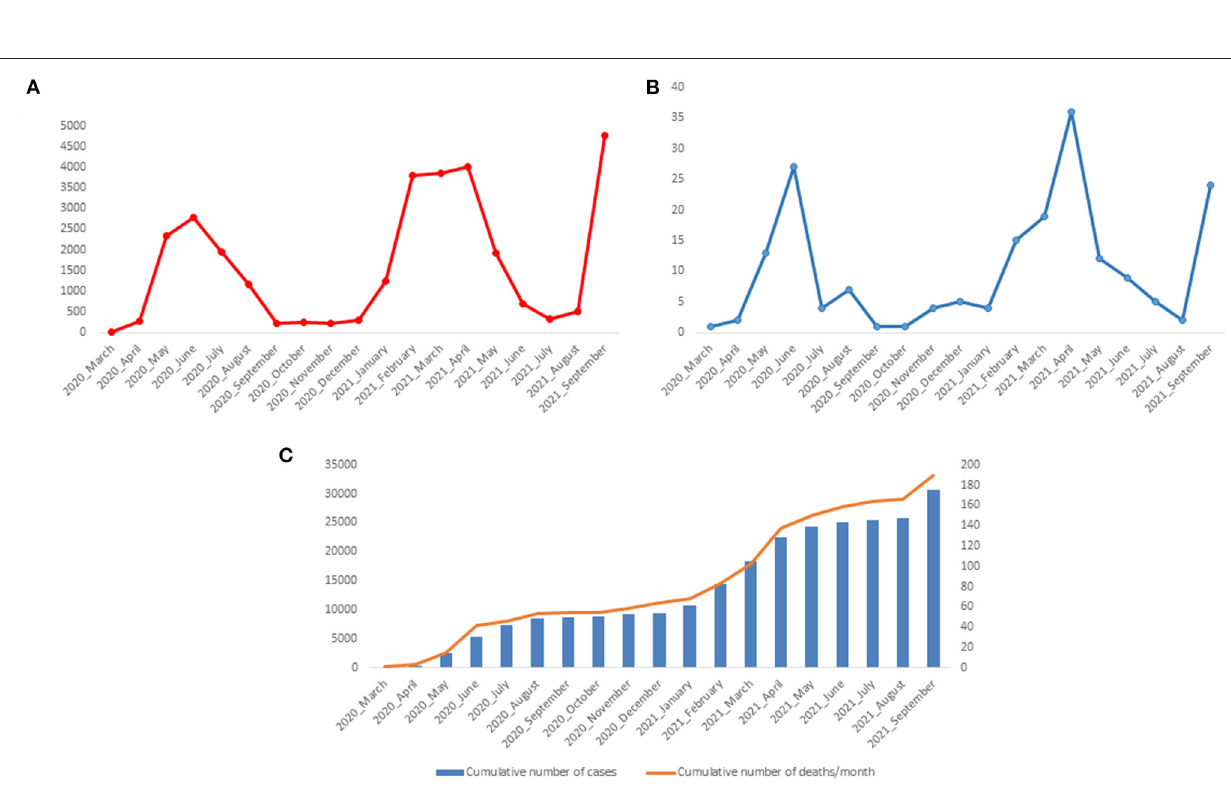
Frontiers in Medicine |